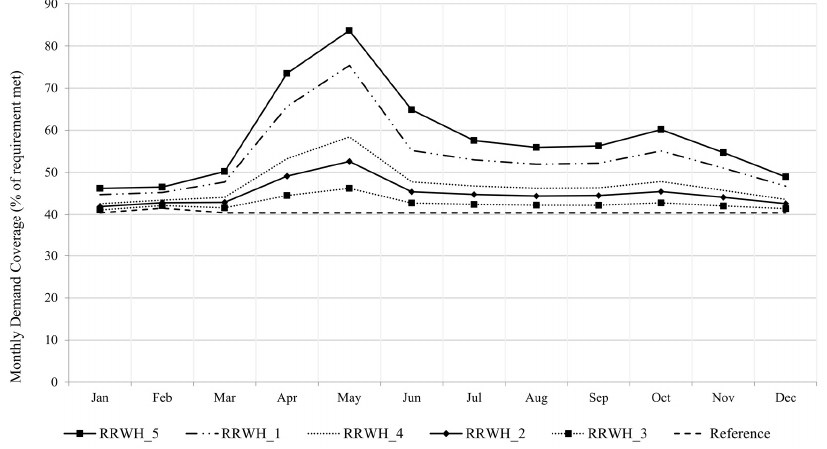
Figure 9. Average monthly demand coverage of RRWH combined with the existing system (2014–2035).